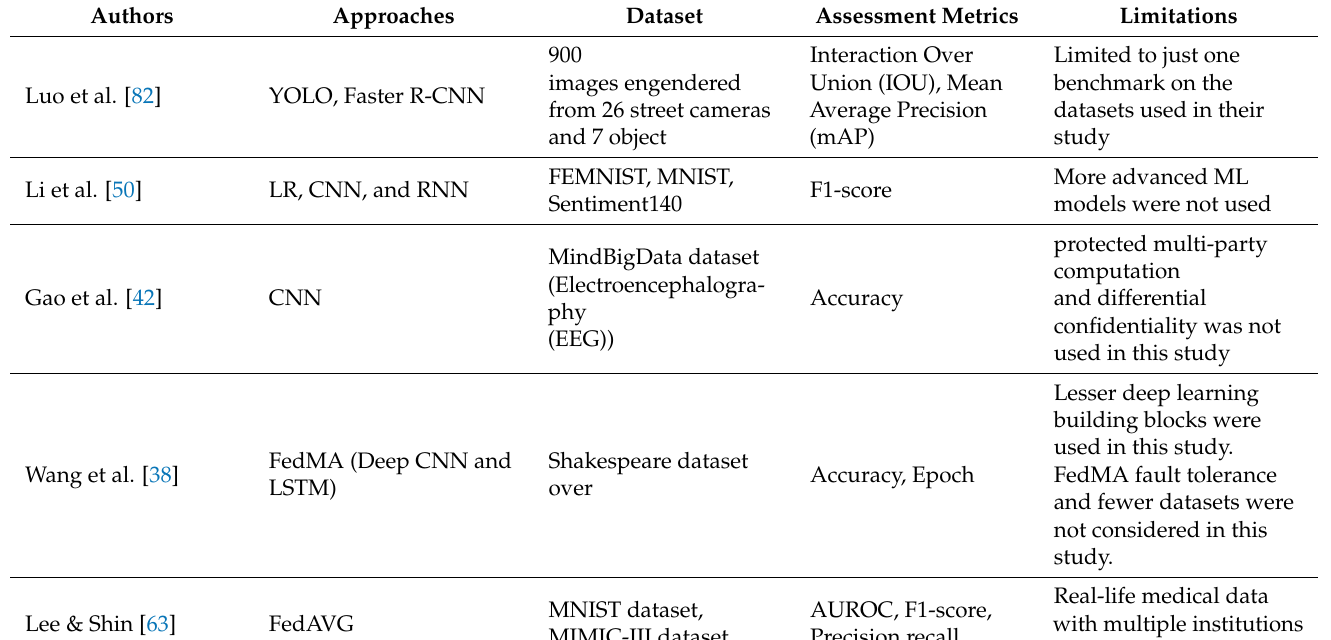
Table 11. Summary of ML algorithms implemented with